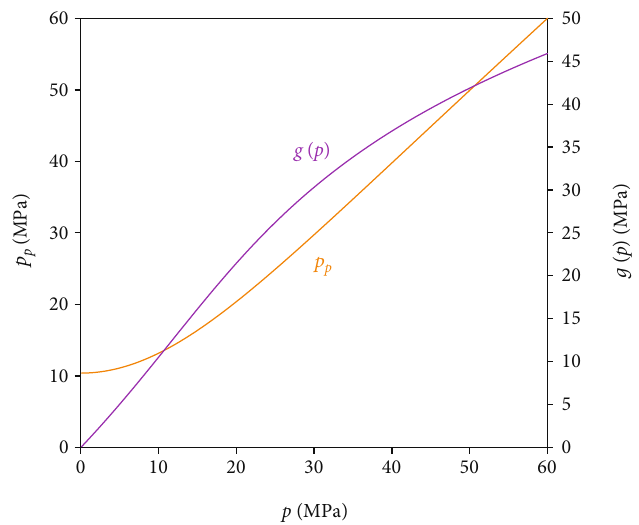
for case studies. pn